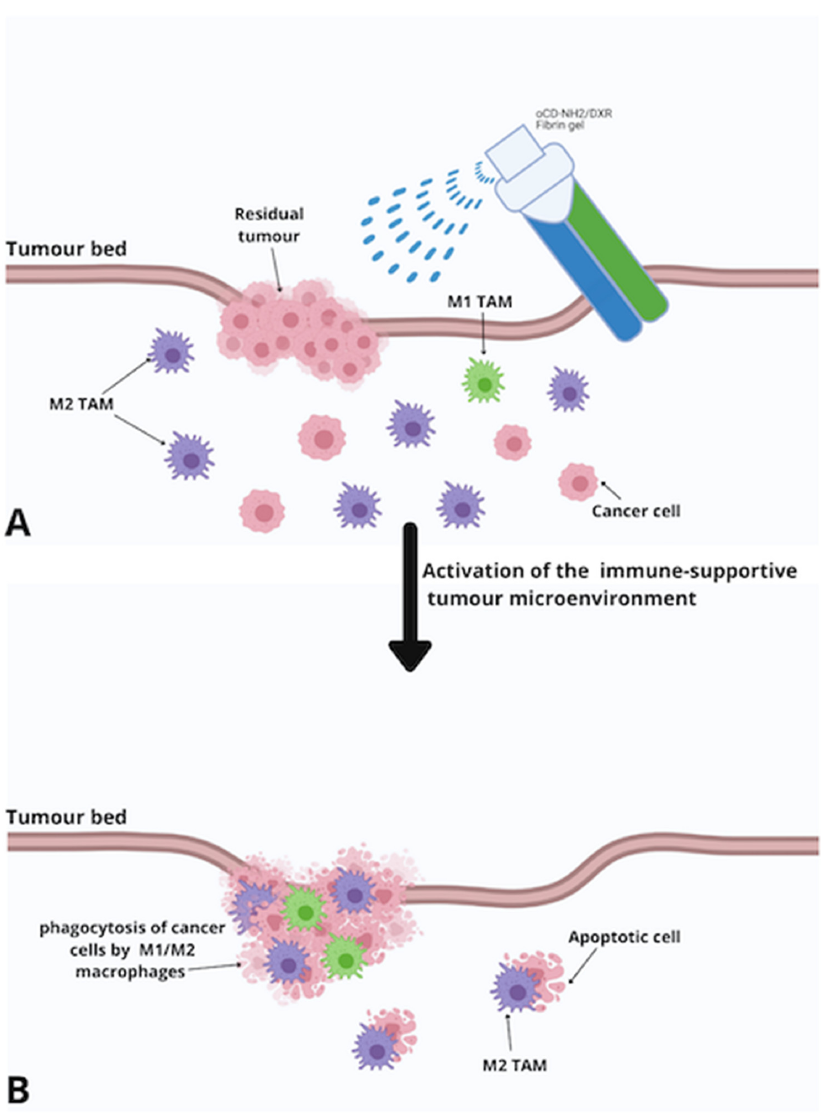
Figure 4. Schematic representation of in-situ-sprayed immunotherapeutic fibrin gel. ( A ) The gel, which contains CaCO 3 nanoparticles encapsulated with the immunotherapeutic antibody, is sprayed on the tumour bed to be gradually released into the tissue. ( B ) CaCO 3 nanoparticles scavenge H+ in the surgical wound site, eliciting an immune-supportive tumour microenvironment after surgery. Cyclodextrins (CD) are used to improve the solubility, delivery, and bioavailability of different drugs, such as doxorubicin, leading to higher drug uptake by cells’ antiproliferative and apoptotic activity. Abbreviations: TAM, tumour-associated macrophage. oCD-NH2/DXR, doxorubicin administered in association with functionalised cyclodextrins.